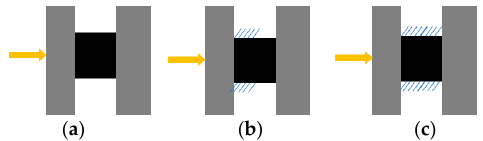
Figure 10. Elastomer seal containment in expandable liner hanger: ( a ) no containment, ( b ) 50% containment, and ( c ) 100% containment.